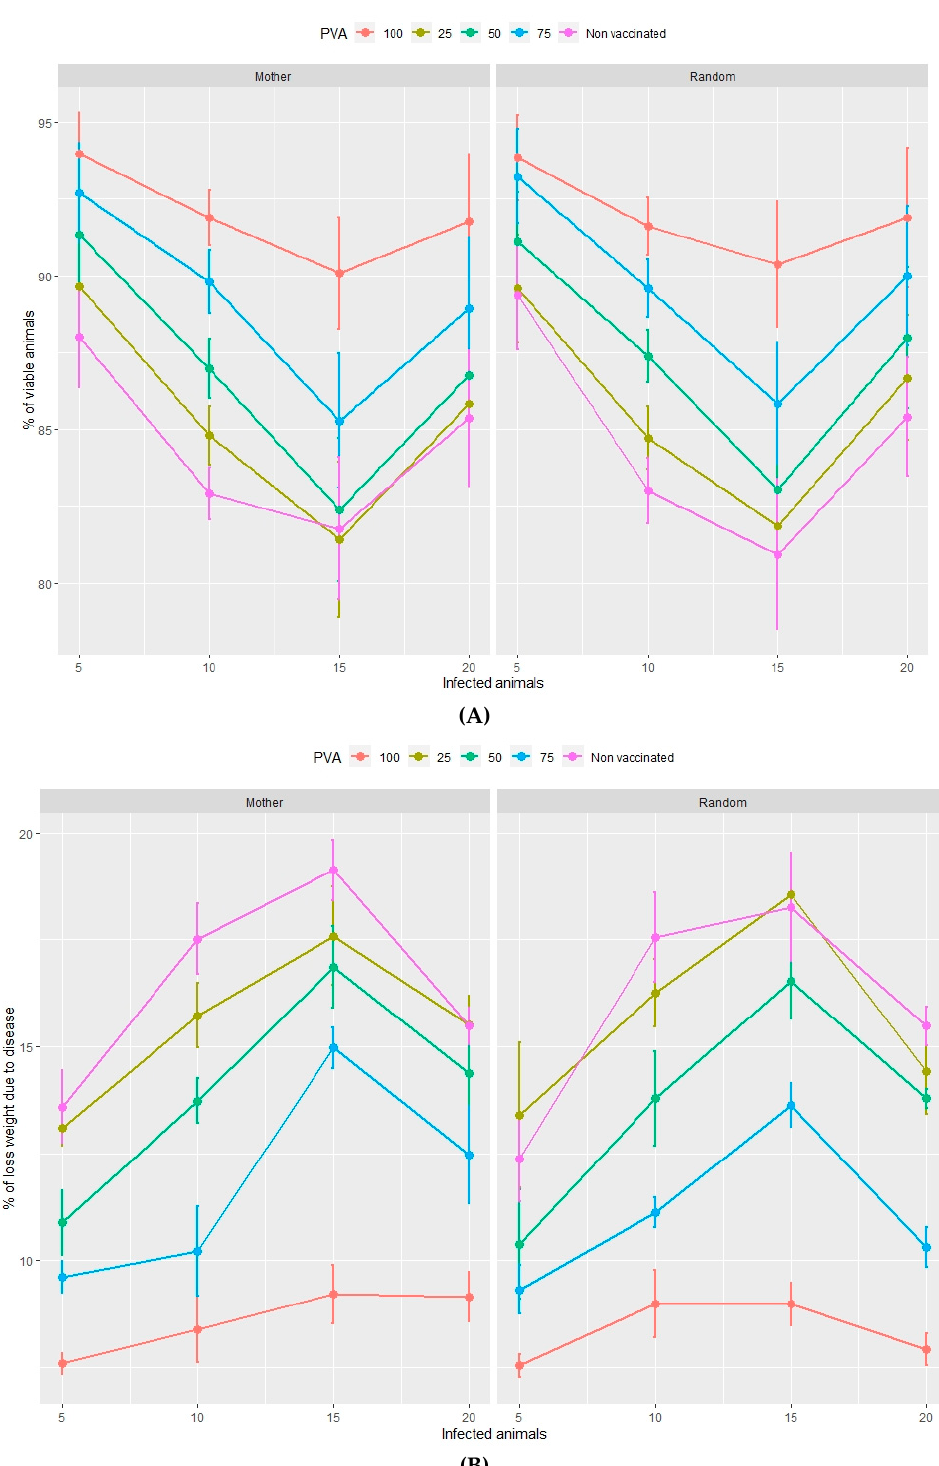
Figure 2. Percentage of viable animals (A) and percentage of total weight loss (B) at the end of the fattening period in relation to the type of management (mother or random), the percentage of vaccinated animals (PVA—ranging from 0%–100% of the population) and the percentage of infected animals at the time of vaccination. Orderly movements of piglets consists of allocating them to nursery pens according to the identity of their mothers and then filling the fattening pens according to the same nursery distribution (Mother) c.f. random movements whereby piglets are allocated to both nursery and fattening pens at random (Random).